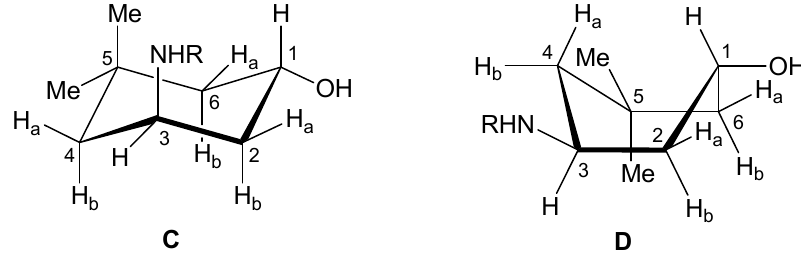
Figure 7. Proposed conformations for the compound trans - 4 in